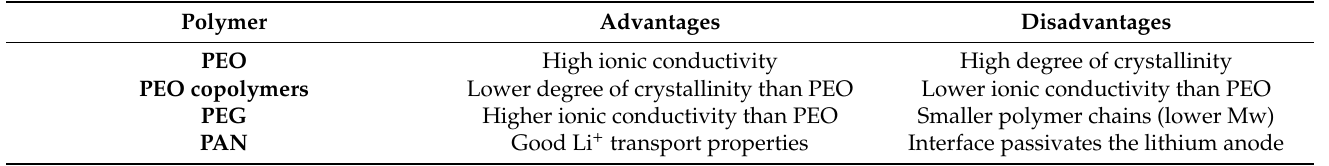
Table 1. Principal advantages and disadvantages of the selected polymers used in this investigation.